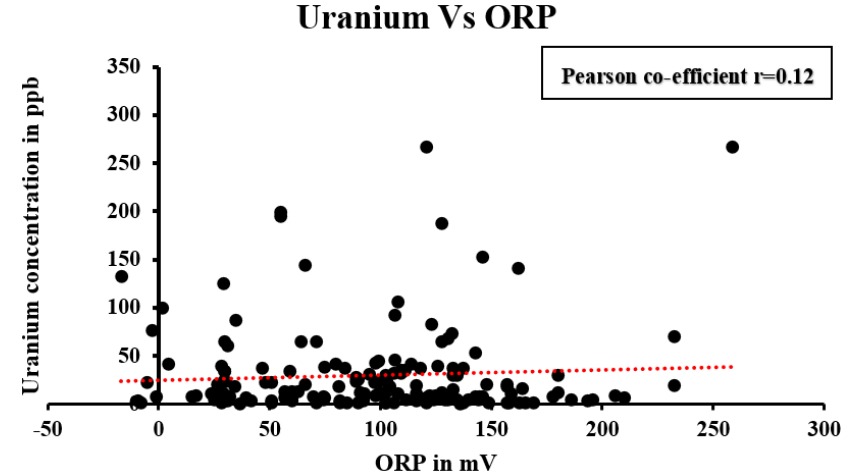
Figure 6. Pearson correlation between uranium concentration and ORP.